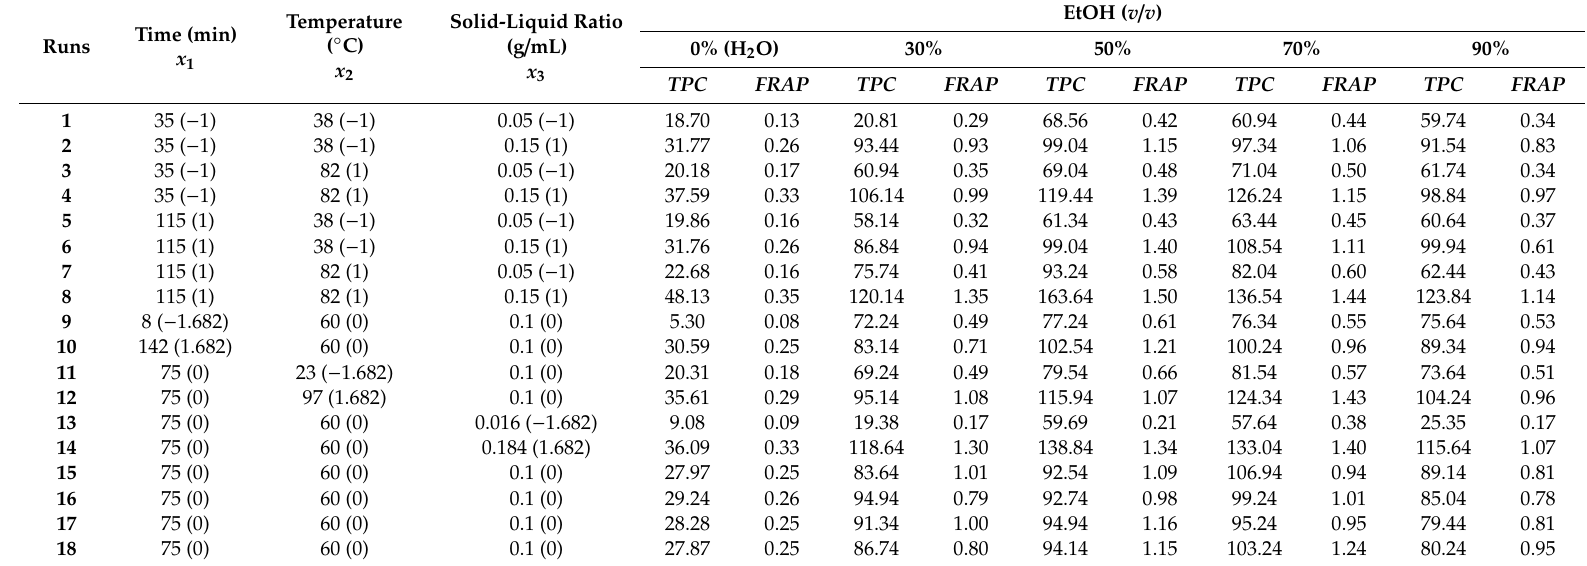
Table 1. Experimental runs using coded levels of time (min, x 1 ), temperature ( ◦ C, x 2 ) and solid: liquid ratio (g / mL, x 3 ) according to the 2 3 full factorial central composite design and data of total phenolic content (TPC) and reducing antioxidant activity (FRAP) of extracts obtained under those conditions for the